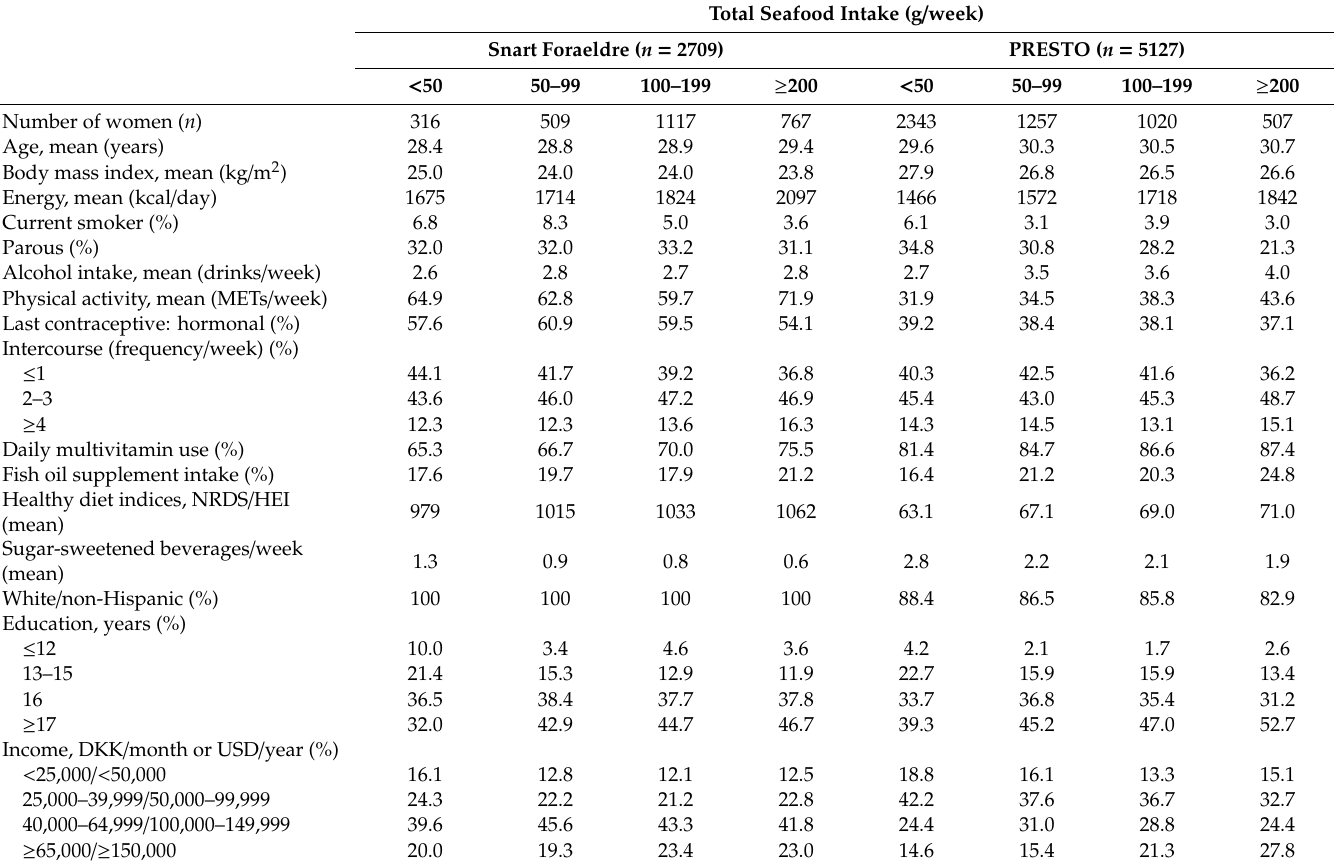
Table 1. Baseline characteristics of participants by dietary intake of seafood, 2013–2018 (Snart Foraeldre) and 2013–2019 (PRESTO) a